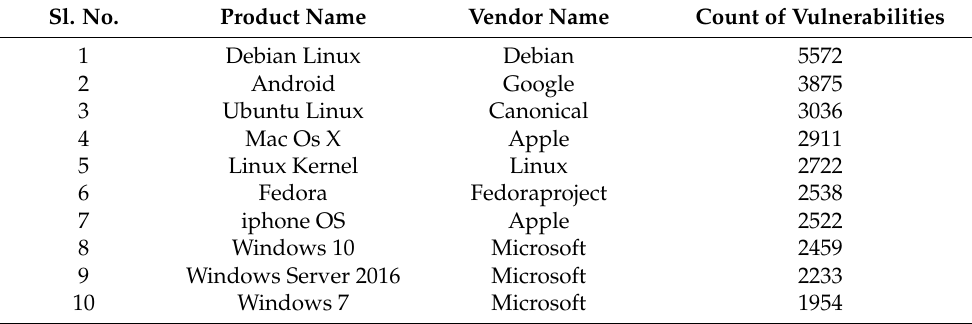
Table 2. Top Operating systems with Vulnerabilities. Sl.